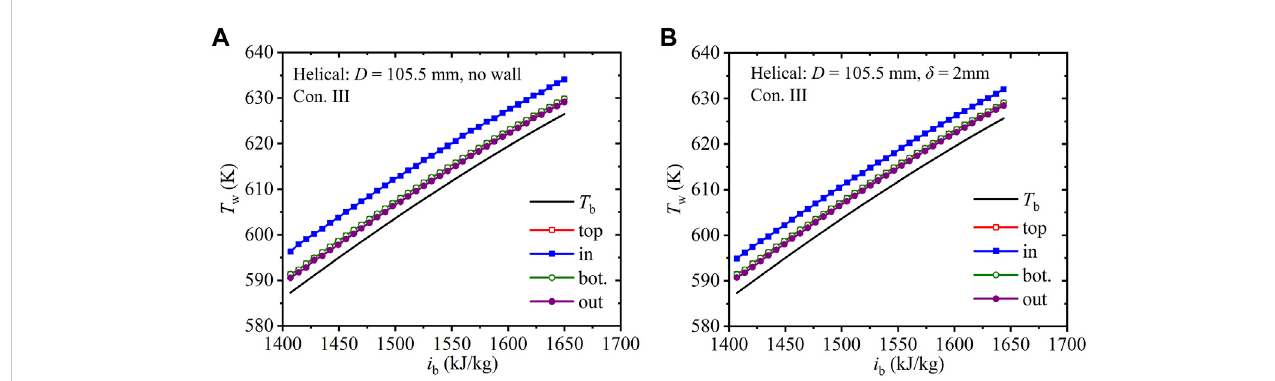
Axialheattransfercoef fi cientsalonghelicaltubeswithvariouswallthicknesses( D =105.5 mm). (A) Nowall-Con.I; (B) 2mmwallthickness-Con.I; (C) No wall-Con. II; (D) 2 mm wall thickness-Con.